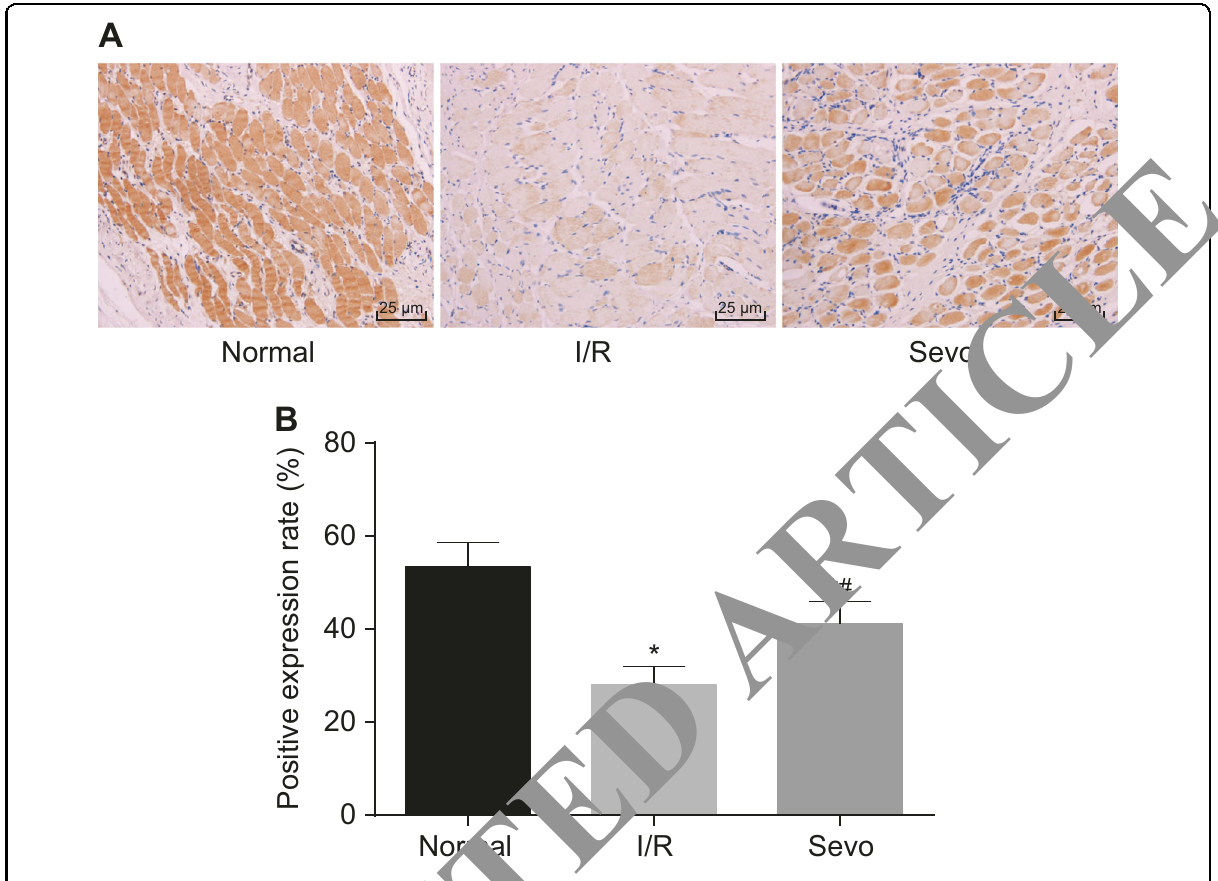
Fig. 3 Immunohistochemistry assays showed the positive expression rate of KCNMA1 (×400). a Images of skeletal muscle tissues acquired after immunohistochemistry assays. b Positive expression rate of KCNMA1. I/R ischemia-reperfusion, Sevo sevo fl urane, KCNMA1 potassium calcium- activated channel subfamily M alpha 1; * p < 0.05 vs. the normal group; # p < 0.05 vs. the I/R group; scale bar = 25 µm; n = 10; measurement data are expressed as the mean ± standard deviation. Comparisons among multiple groups were performed by one-way ANOVA; the experiment was repeated 3